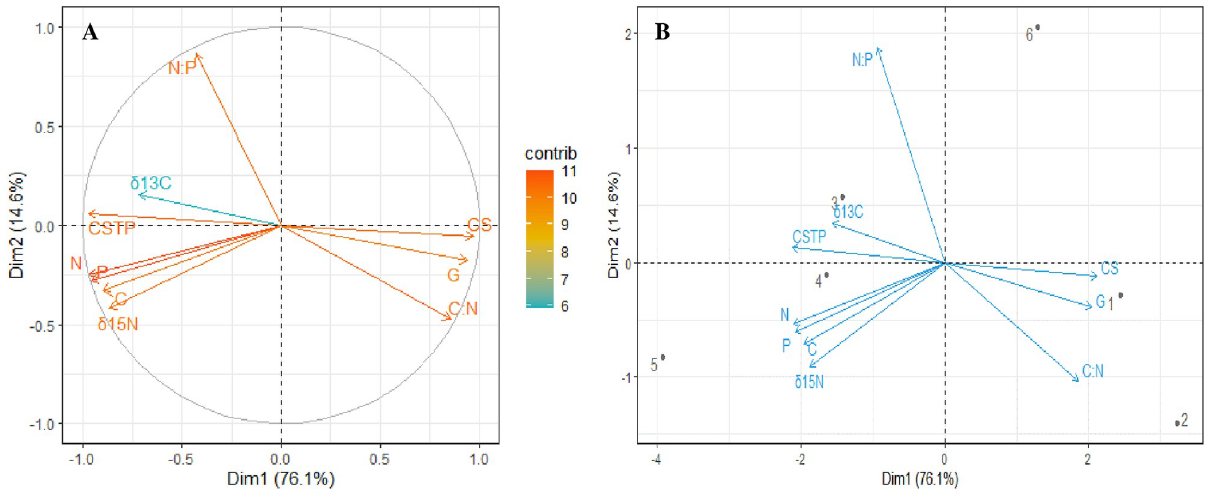
Fig 2. The (A) contribution plot and (B) biplot of a principal component analysis conducted to examine the relationship between sediment grain size and nutrients. C—Total organic carbon, N—Total nitrogen, P—Total phosphorus, δ 13 C—Carbon isotope, δ 15 N—Nitrogen isotope, C:N— Carbon-Nitrogen ratio, N:P—Nitrogen-Phosphorus ratio, CS—Coarse sandy, CSTP—Clay and Silt particles, G–Gravels, 1–8—Study areas (1-Al Lith, 2-South Jeddah, 3-Dahaban, 4-Thuwal, 5-Rabigh and 6-Mastorah).